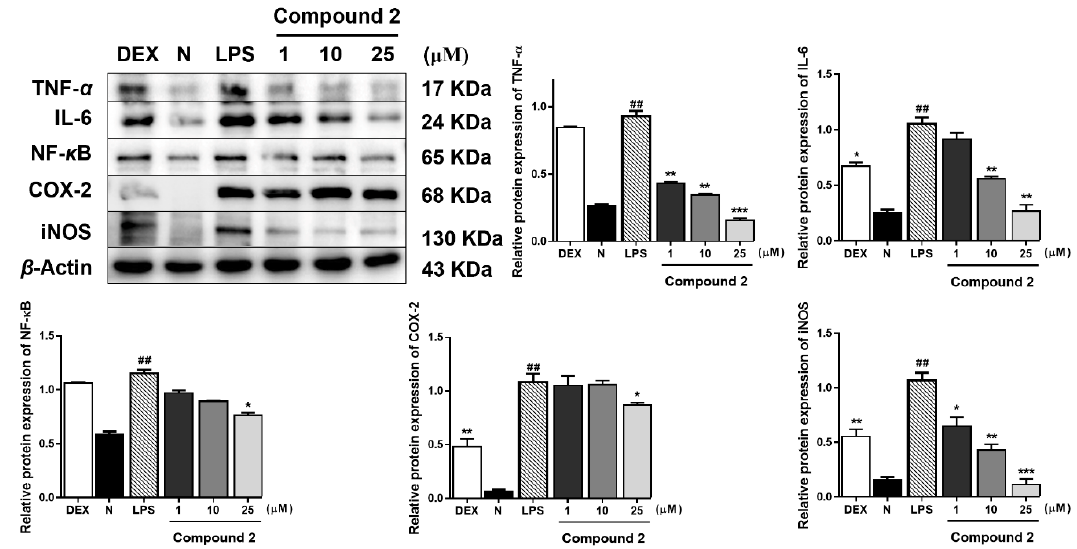
Figure 4. Inhibitory effects of compound 2 on the protein expression of TNF- α , IL-6, COX-2, NF- κ B, and iNOS in RAW 264.7 cells. Normal: normal group without LPS, DEX, and other tested samples. Values represent the mean ± SEM of three determinations. * p < 0.05; ** p < 0.01; *** p < 0.001; (Differences between compound-treated group and control group). ## p < 0.01 (Differences between LPS-treated group and control group). n = 3.